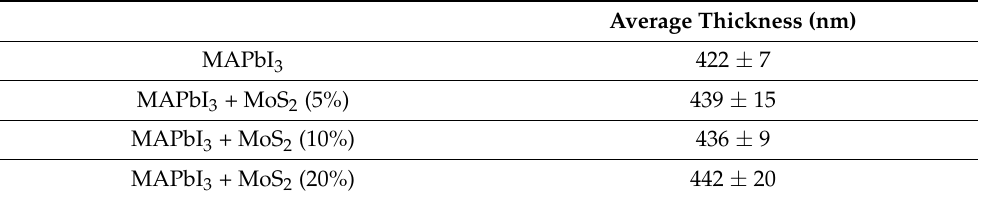
Figure 3. Top-view SEM images of the as-prepared MAPbI 3 perovskite films, with and without MoS 2 additive: ( a ) MAPbI 3 ; ( b ) MAPbI 3 + MoS 2 (5%); ( c ) MAPbI 3 + MoS 2 (10%); ( d ) MAPbI 3 + MoS 2 (20%). In the insets are reported the photographs of the corresponding perovskite films coated on glass/ITO/PTAA substrates. Table 1. MAPbI 3 film thicknesses, with and without MoS 2